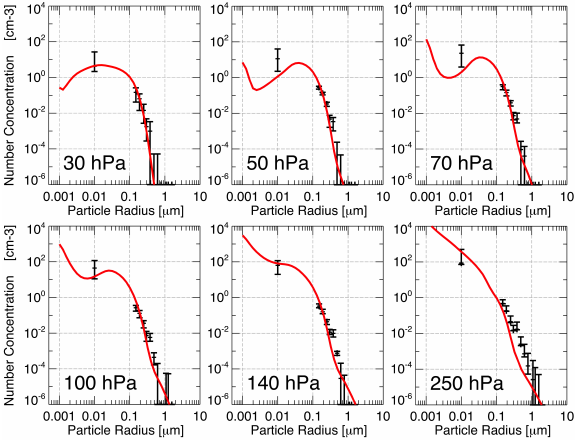
Fig. 11. Comparison of modelled size distributions with OPC mea- surements of particle number concentrations taken in the free tropo- sphere and stratosphere over Laramie, WY for 2006 (Deshler et al., 2003a). Model data are represented by annual zonal means. For the OPC the median of all soundings in 2006, rebinned to the vertical resolution of the model, is shown. Whiskers denote the spread of the observations.